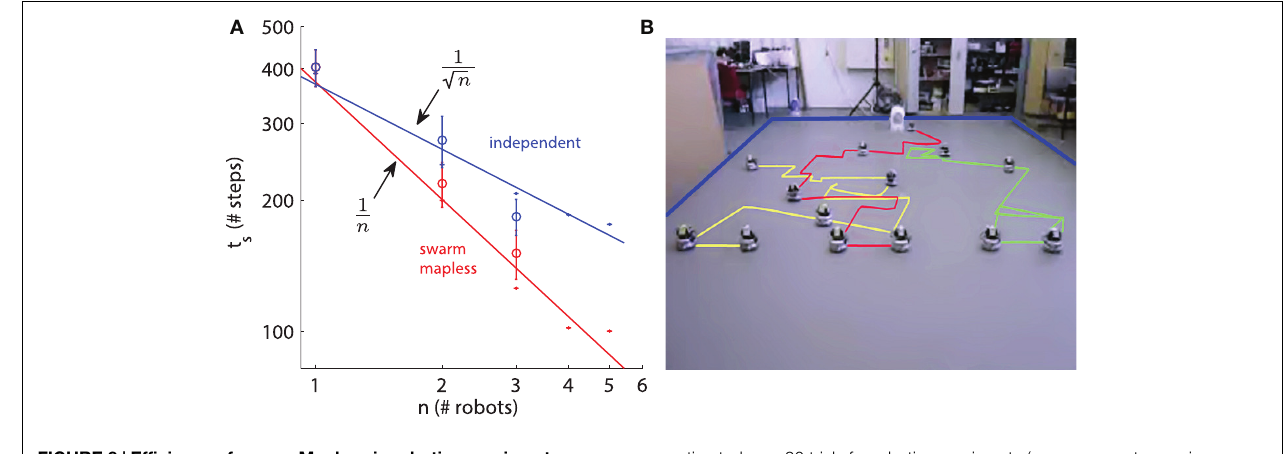
FIGURE 8 | Efficiency of swarm Mapless in robotic experiments . (A) Dependency of the search time (number of steps) on the number of searchers in log–log scale for robotic experiments (circles) and simulations (points and power law fits from Figure 1A ). Results are means ± SEM